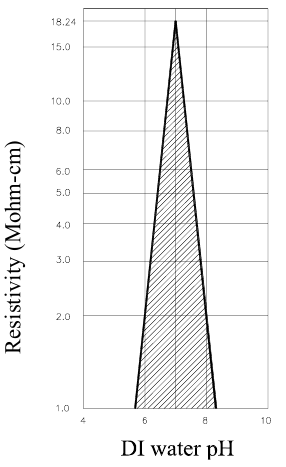
Figure 7: Resistivity limits of DI